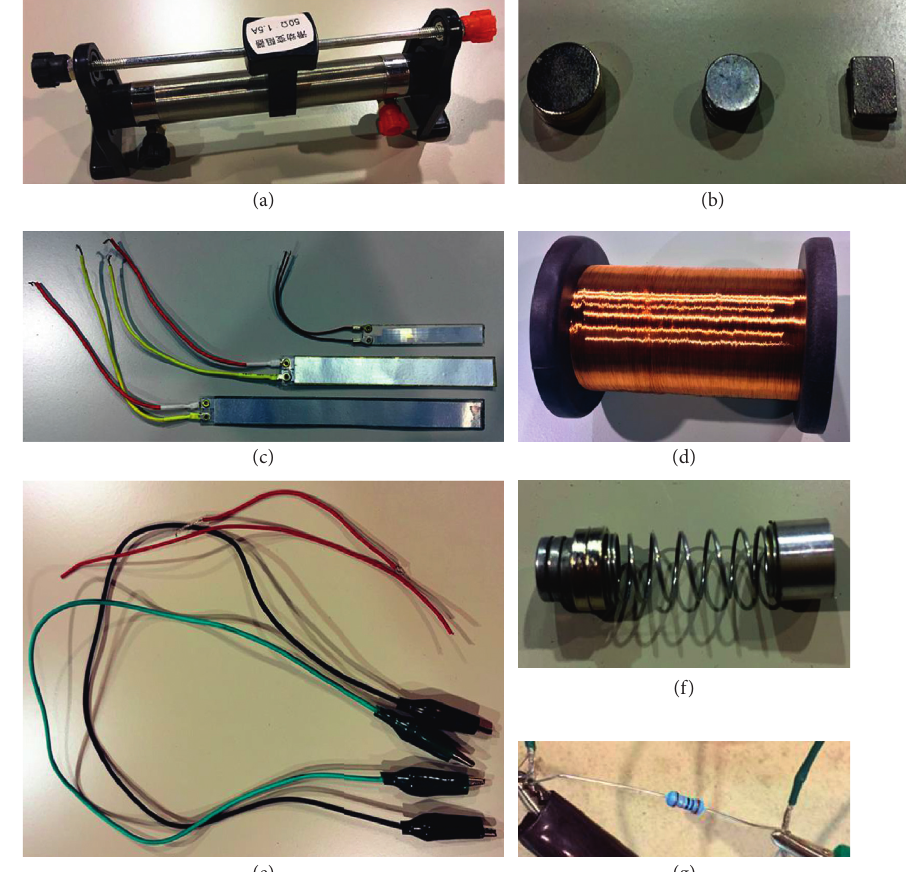
Figure 2: Experimental materials: (a) variable resistance; (b) magnet; (c) PVDF piezoelectric beam; (d) coil; (e) wire; (f) spring and magnet connection; (g)